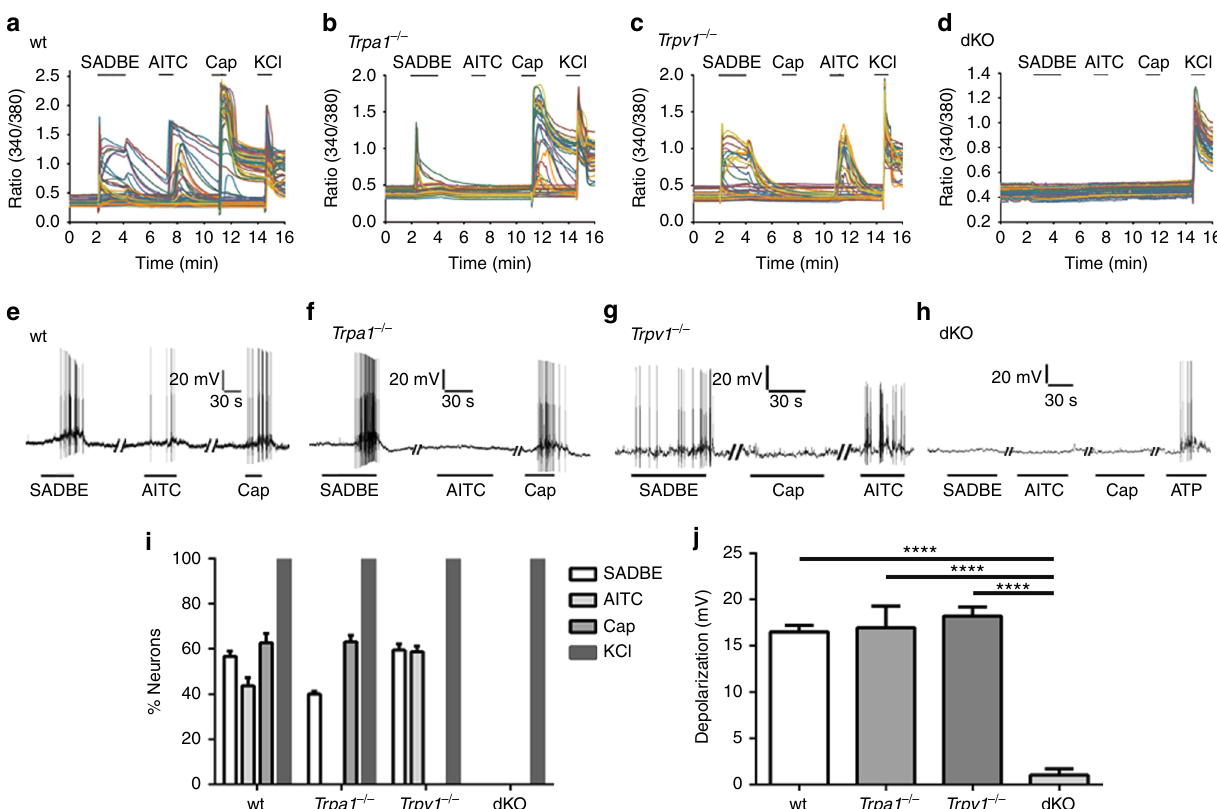
Fig. 3 Genetic ablation of TRPA1/TRPV1 abolishes SADBE-induced activation of DRG. a – d Representative time-lapse traces show that SADBE-induced a robust [Ca 2+ ] i response in 56.7% of wt (317/558, a ), 40.2% of Trpa1 − / − (220/547, b ), 59.5% of Trpv1 − / − (334/561, c ), and 0% of Trpa1 − / − / Trpv1 − / − dKO (0/509, d ) DRG neurons. n = 5 coverslips for each genotype; e – h Representative traces show that SADBE-induced depolarization of membrane potential and action potential fi ring in DRG neurons isolated from wt ( e ), Trpa1 − / − ( f ), Trpv1 − / − ( g ) and Trpa1 − / − / Trpv1 − / − dKO ( h ) mice, n = 5 for each genotype; ( i ) Percentages of DRG neurons responding to SADBE, AITC, capsaicin and KCl in neurons isolated from wt, Trpa1 − / − , Trpv1 − / − and Trpa1 − / − / Trpv1 − / − dKO mice in live-cell Ca 2+ imaging assays. Data are presented as mean ± SEM; ( j ) Quanti fi cation of SADBE-induced depolarization of membrane potentials of DRG neurons isolated from wt, Trpa1 − / − , Trpv1 − / − and Trpa1 − / − / Trpv1 − / − dKO mice. Data are presented as mean ± SEM. Asterisks indicate statistical signi fi cance. **** p < 0.0001,